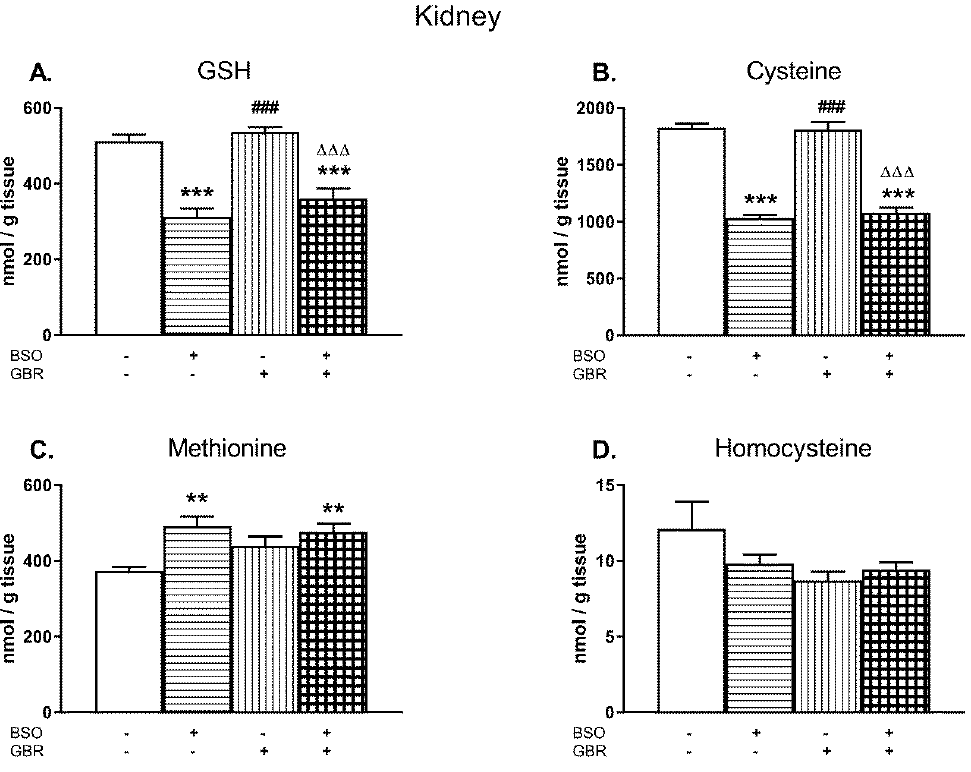
Figure 2. The effects of chronic administration of BSO and GBR 12909, alone or in combination, on the levels of GSH ( A ), Cys ( B ), Met ( C ), and Hcy ( D ) in the kidney of 16-day-old rats. Data expressed in nmole/g of tissue are presented as the mean ± SEM, n = 7–8 for each group. Statistical analysis was performed using a two-way ANOVA; symbols indicate significance of differences according to the Newman–Keuls post-hoc test, ** p < 0.01, *** p < 0.001 vs. control; ### p < 0.001 vs. BSO-; and ∆∆∆ p < 0.001 vs. GBR 12909-treated groups.